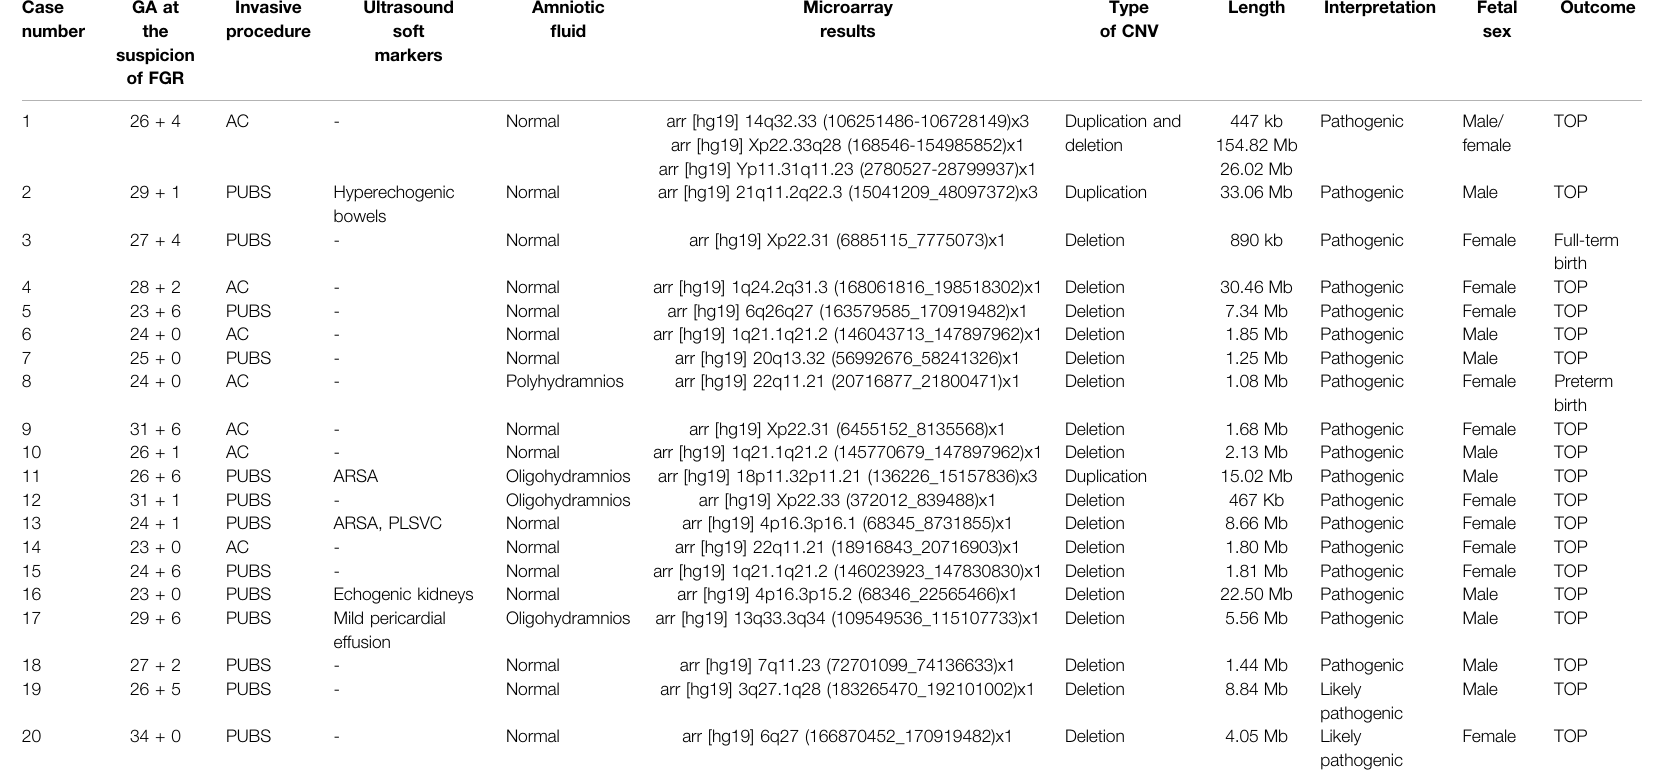
GA, gestational age; FGR, fetal grow restriction; CNV, copy number variation; T18, Trisomy 18; T21, Trisomy 21; AC, amniocentesis; PUBS, percutaneous umbilical blood sampling; ARSA, aberrant right subclavicular artery; PLSVC, persistent left superior vena cava; TOP, termination of